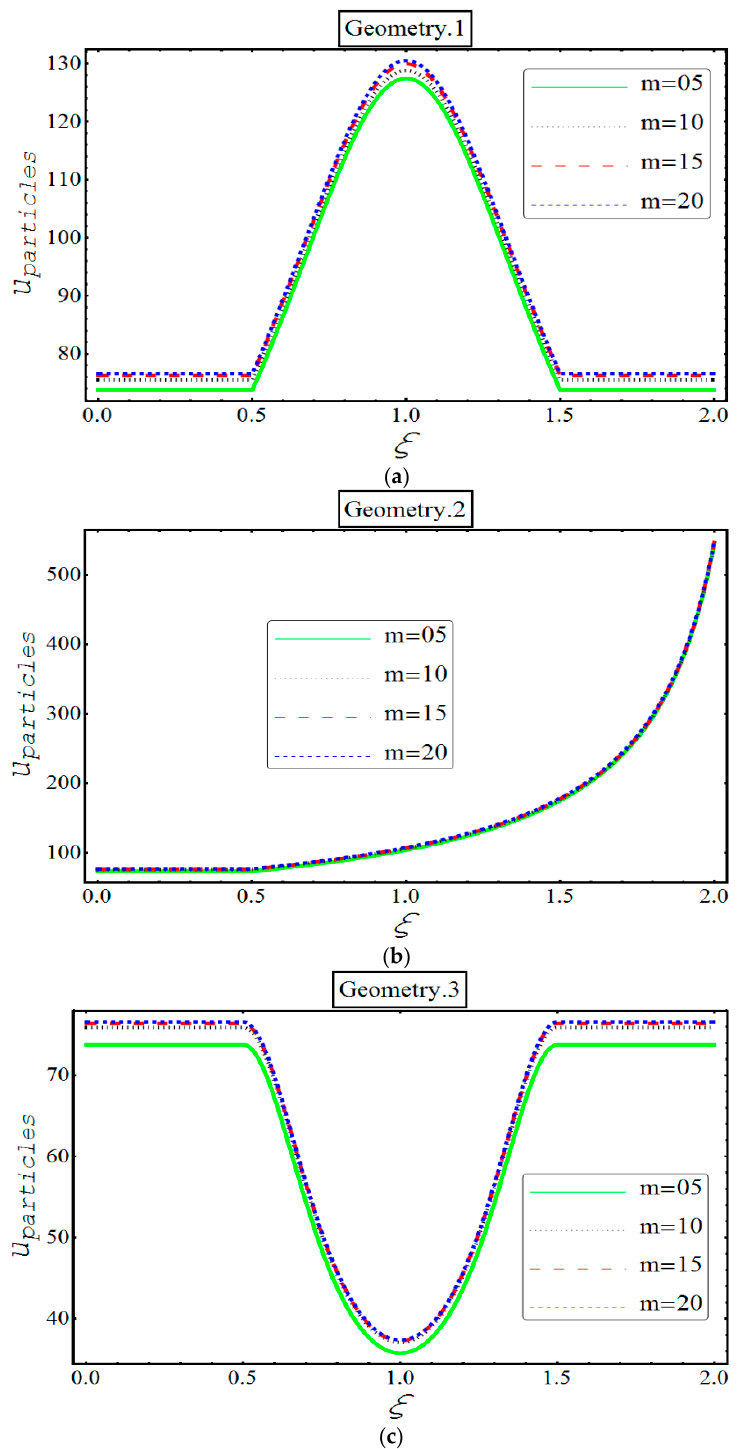
Figure 7. Variation of the velocity (cid:1873) (cid:3043) for various electro-osmotic parameters.